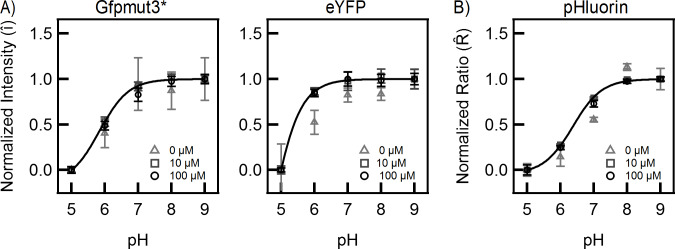
Normalized emission intensities and ratios as a function of cytoplasmic pH.(A) Normalized curves for Gfpmut3* (left panel) and eYFP (right panel) are indicated at different induction levels. The solid curves represent fits with Eq 5 with a single fit parameter, K. K = (1.8 ± 0.13)×103 protons for Gfpmut3*; K = (2.9 ± 1.4)×104 protons for eYFP. (B) The normalized emission ratios over a range of pH for pHluorin are indicated. The solid curve represents fits with Eq 5; K = 540 ± 24 protons.